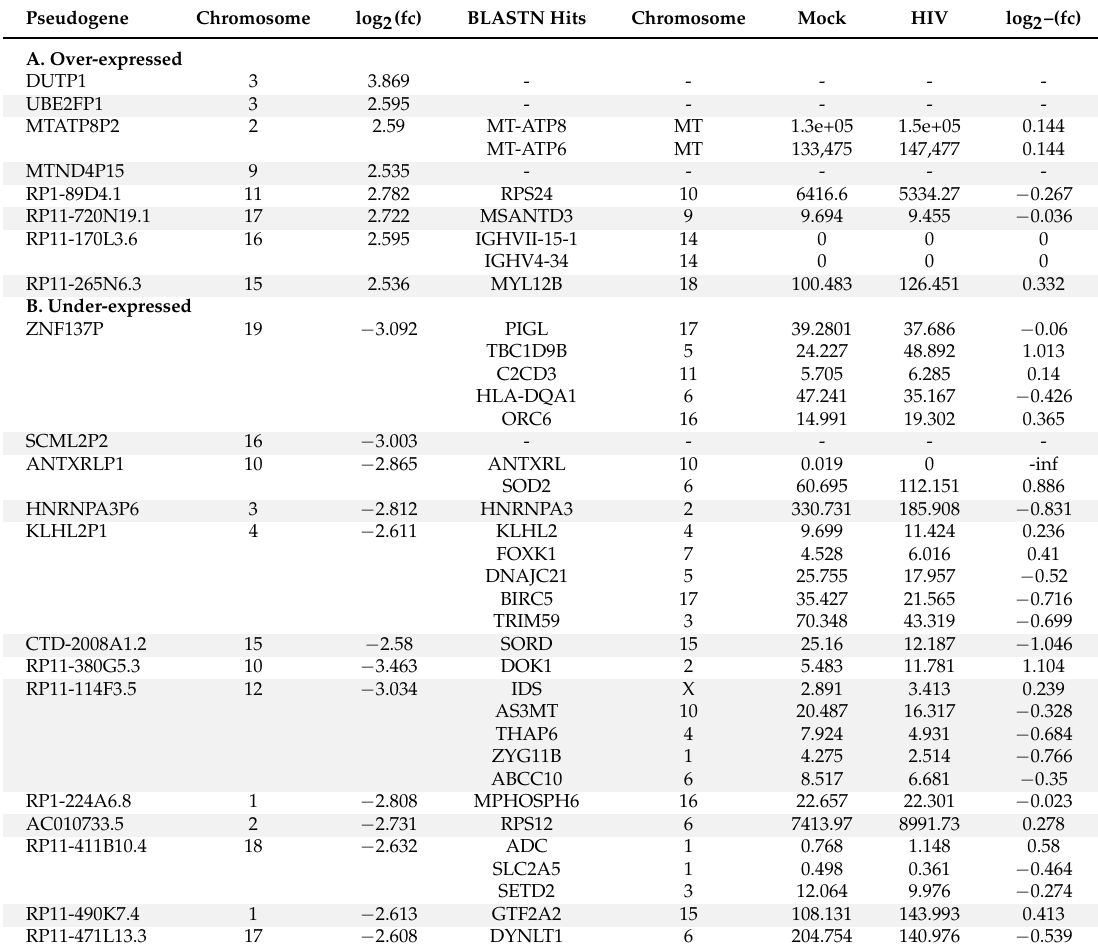
Table 3. BLASTN hits (transcripts/splice variants) for differentially-expressed pseudogenes. Only hits to known protein-coding genes with E-value < 10 − 4 and sequence similarity >90% are shown. “fc” denotes fold change in gene expression; “Mock” represents gene expression in uninfected T-cells; and “HIV” denotes gene expression in HIV-1-infected T-cells 7 days